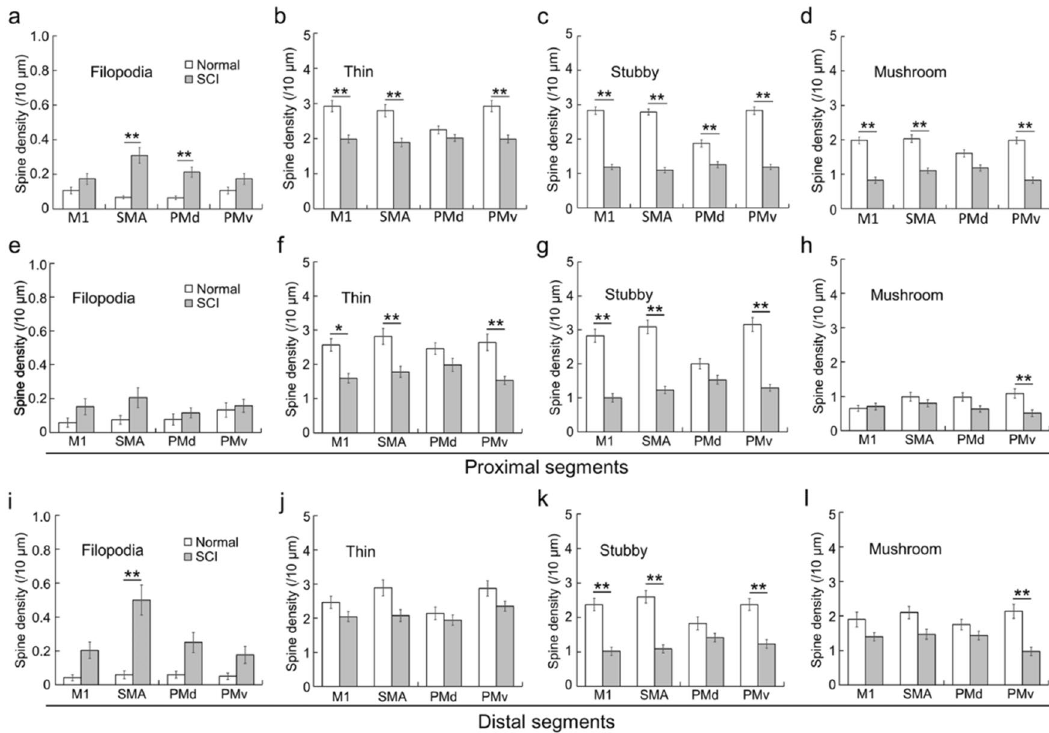
Figure 6. Density changes post-SCI of filopodia-, thin-, stubby-, and mushroom-type spines of basal dendrites of large layer V pyramidal neurons in frontal motor-related areas. ( a ) Increase in the density of filopodia-type spines. ( b – d ) Decreases in the density of thin-, stubby-, and mushroom-type spines. ( e – l ) Alterations in the density of filopodia-, thin-, stubby-, and mushroom-type spines on the proximal (30–60 µm from the dendritic origin; ( e – h ) and distal (30 µm from the dendritic tip; ( i – l ) segments of basal dendrites. Two-way ANOVA with the Bonferroni post hoc test. * p < 0.05, ** p <